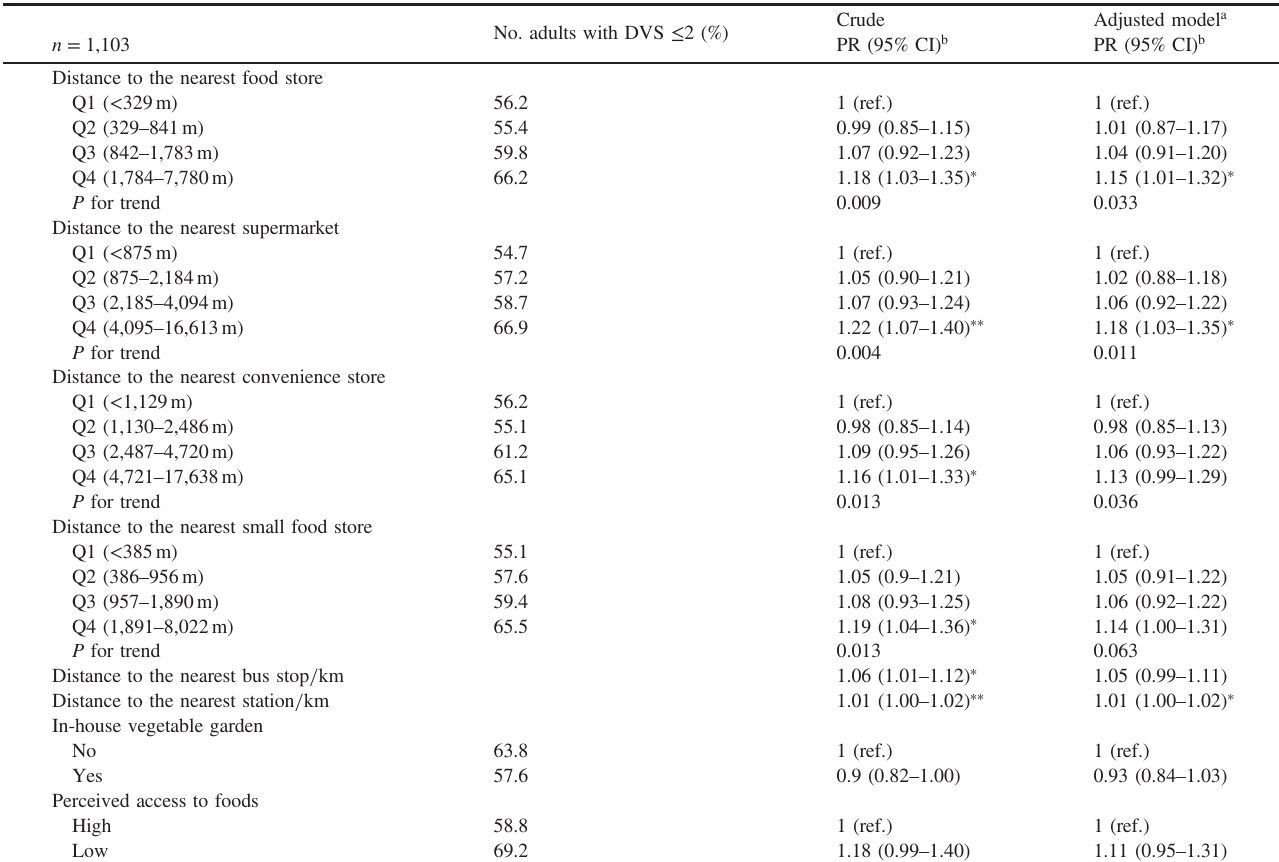
Table 2. Prevalence ratio (95% con fi dence interval) for the low diet variety score (DVS) for neighborhood food environment